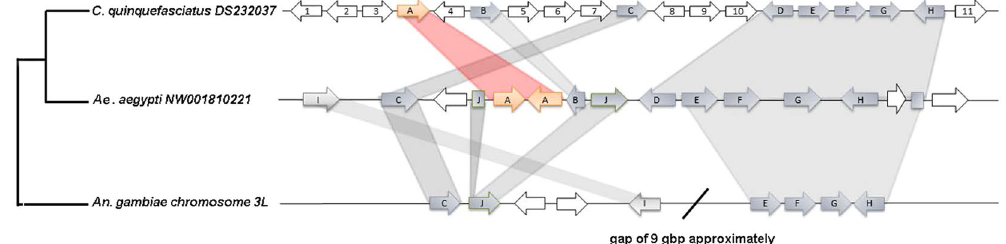
Figure 3. Schematic representation of the shared genomic context between C. quinquefasciatus (DS232037), Aedes aegypti (NW001810221) and Anopheles gambiae (chromosome 3L). Grey shadows link conserved syntenic ORFs. RIP genes are represented with orange arrows. The ORF 4 is equivalent to XM_001850822 and is absent in other scaffolds. Additional information about each gene is available in Supplementary Table 1.